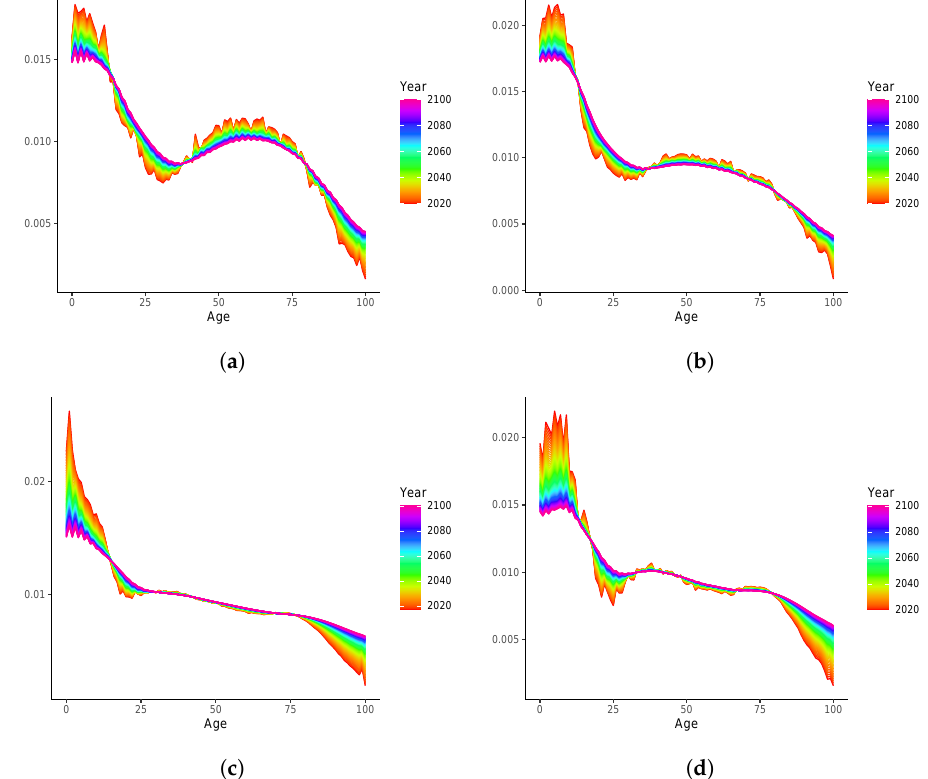
Figure 6. Projected rotation of age-specific mortality decline (ˆ b x , T + h ), 2020–2100: ( a ) Australia; ( b ) Canada; ( c ) Spain; ( d )